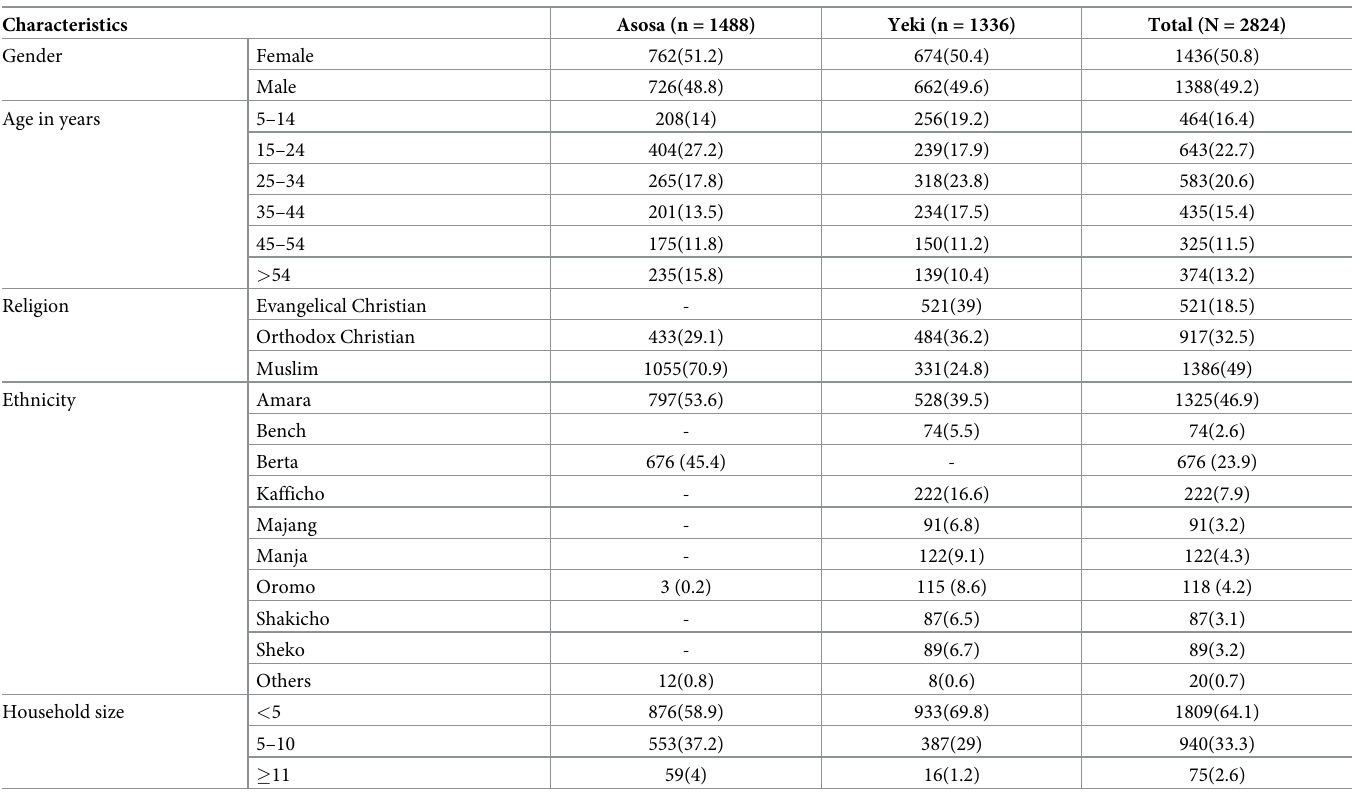
Table 1. Socio-demographic profiles of the respondents in Asosa and Yeki districts (2017).